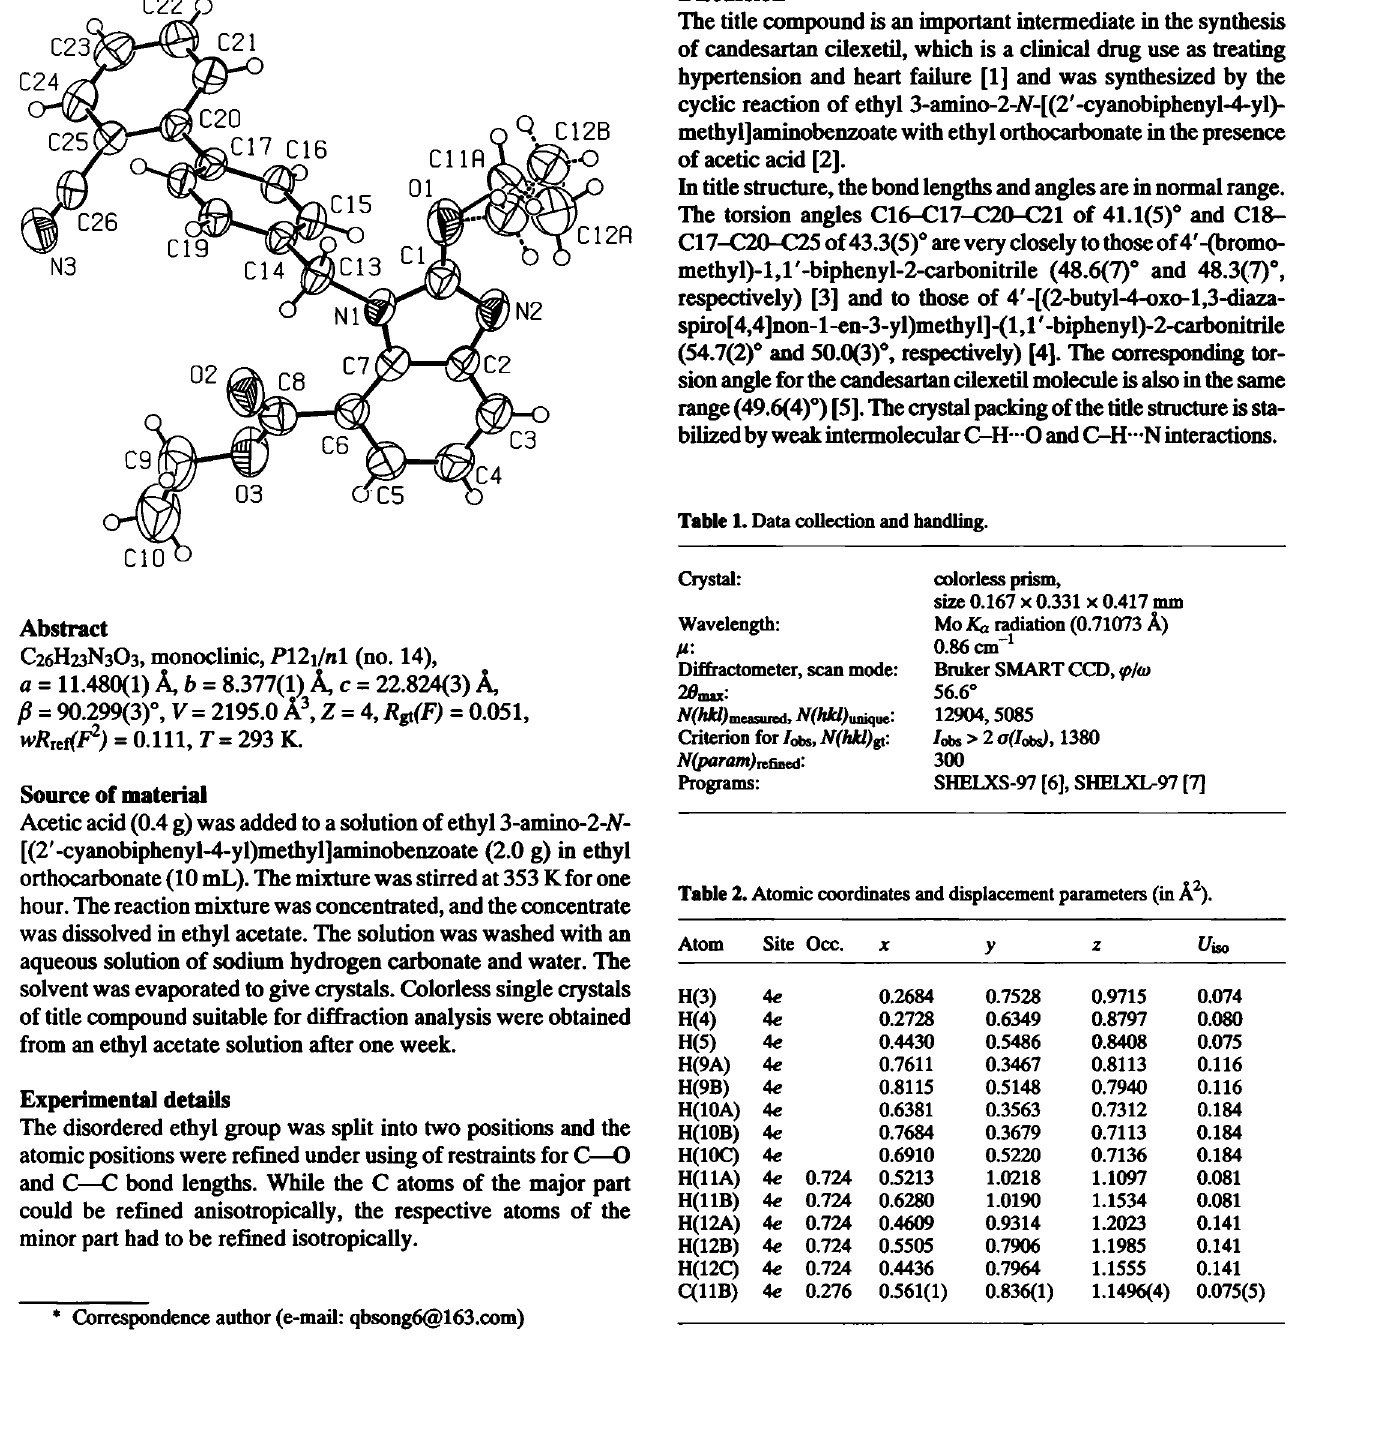
Table I. Data collection and handling.